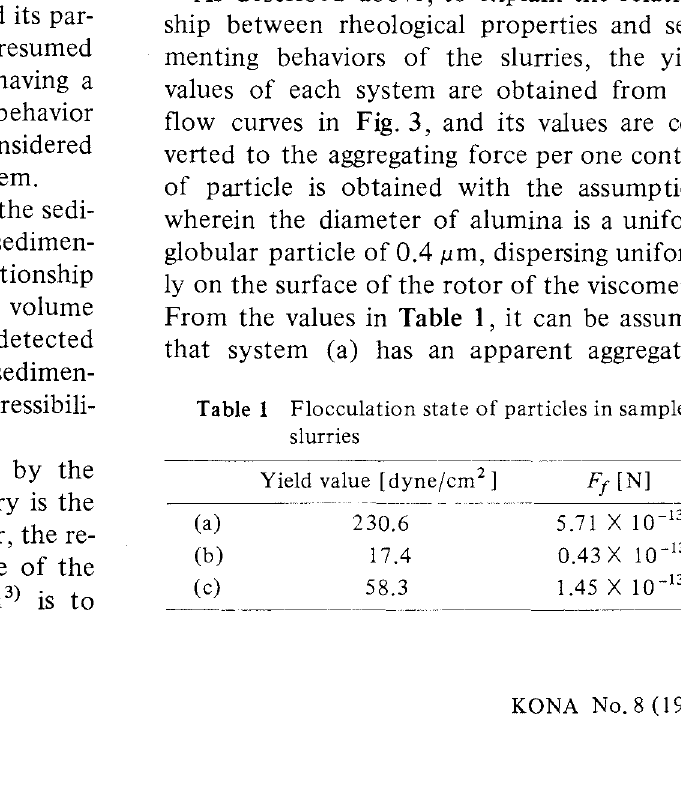
Fig. 4 Change of sedimentation volume as sedimen tation time